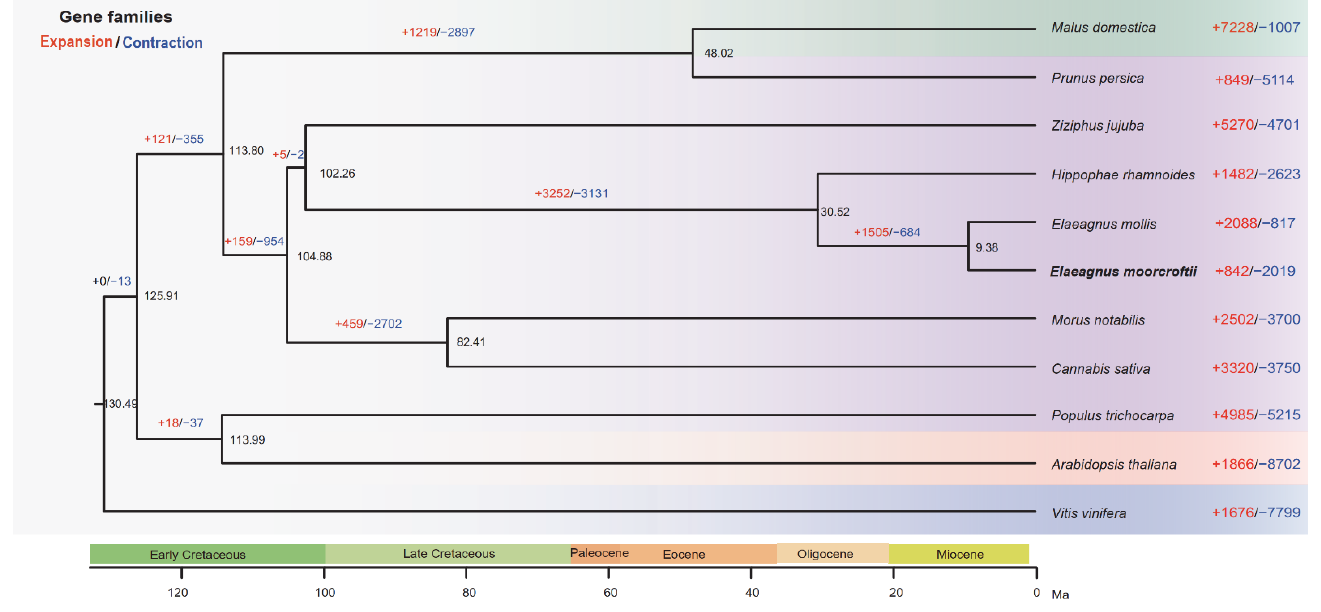
Figure 2. Comparative and evolutionary genomic analysis of E. moorcroftii and 10 other plant species. A phylogenetic tree among 11 species was reconstructed based on 175 single-copy genes, and their divergence times were also estimated. The numbers of expansion (blue) and contraction (red) gene families are shown above the branches.